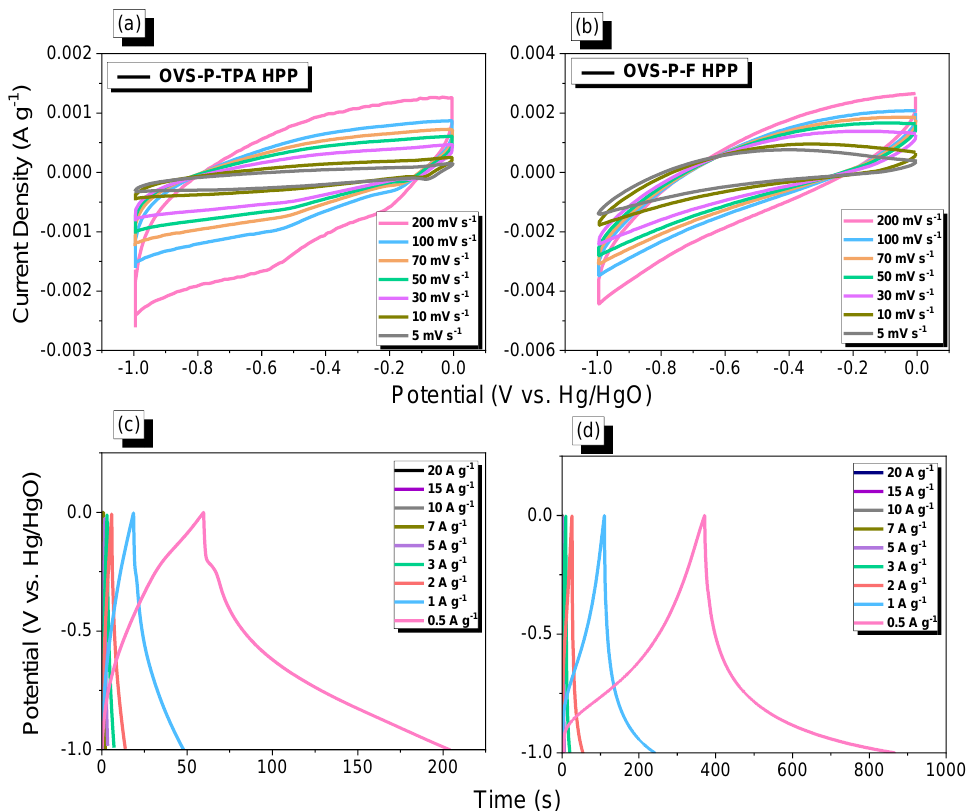
Figure 6. CV and GCD curves of ( a , c ) OVS-P-TPA HPP and ( b , d ) OVS-P-F HPP.